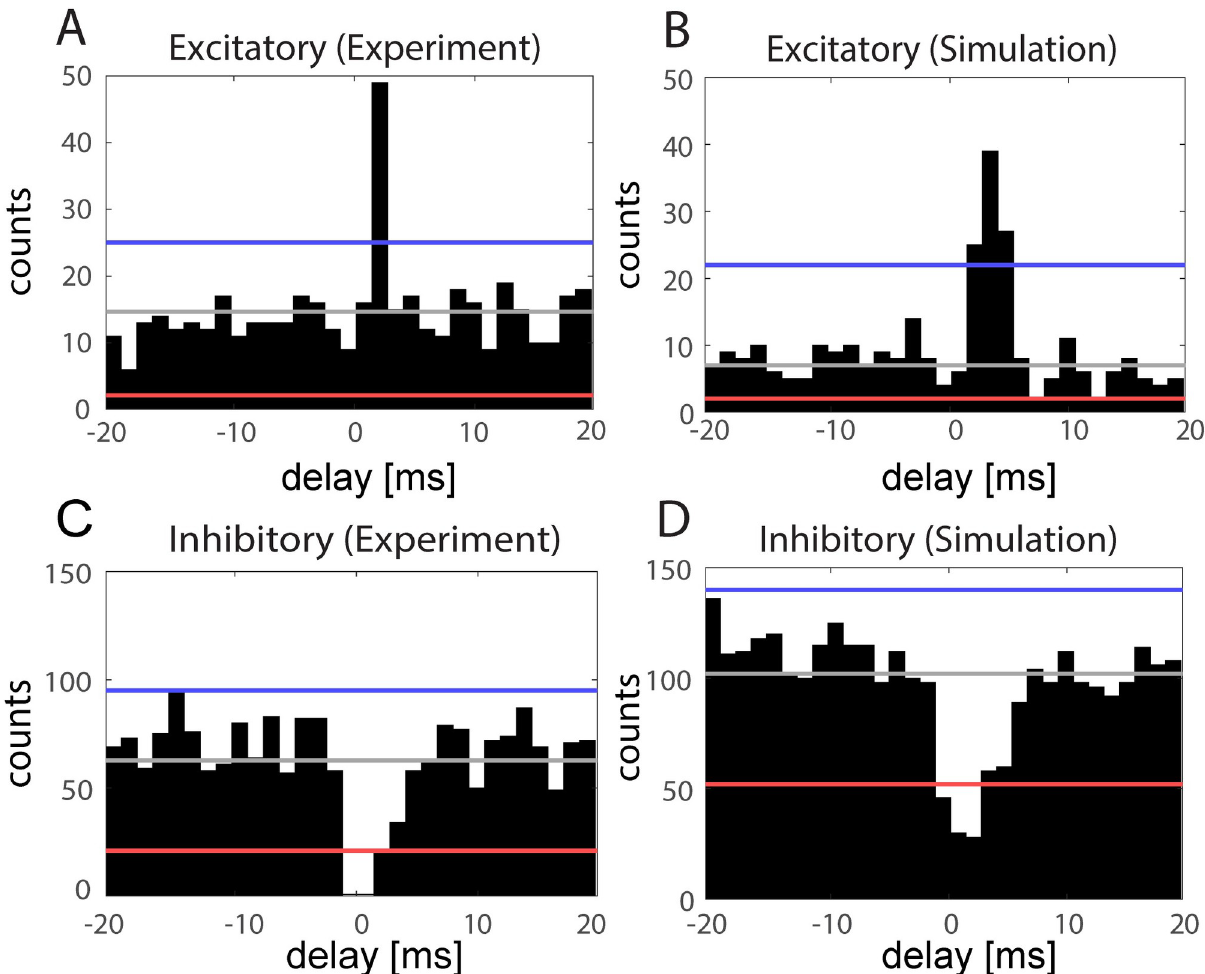
Fig 10. Cross Correlogram computes coincident spike relations by summing relative spike times of reference and comparison neurons. . A-D) . Cross correlograms between example pairs of “reference” and “comparison” cells, centered at spike times of the “reference” cell, from the experimental recordings (left column) and simulated networks (right column). Significance bands were computed from a jittered data set of “comparison” cell spike times (gray line = mean of jittered data set, red line = excitatory significance, blue line = inhibitory significance, see text). A-B) Example cross correlograms showing significant excitatory connections between cell pairs. C, D) Example cross correlograms showing significant inhibitory connections between cell pairs.